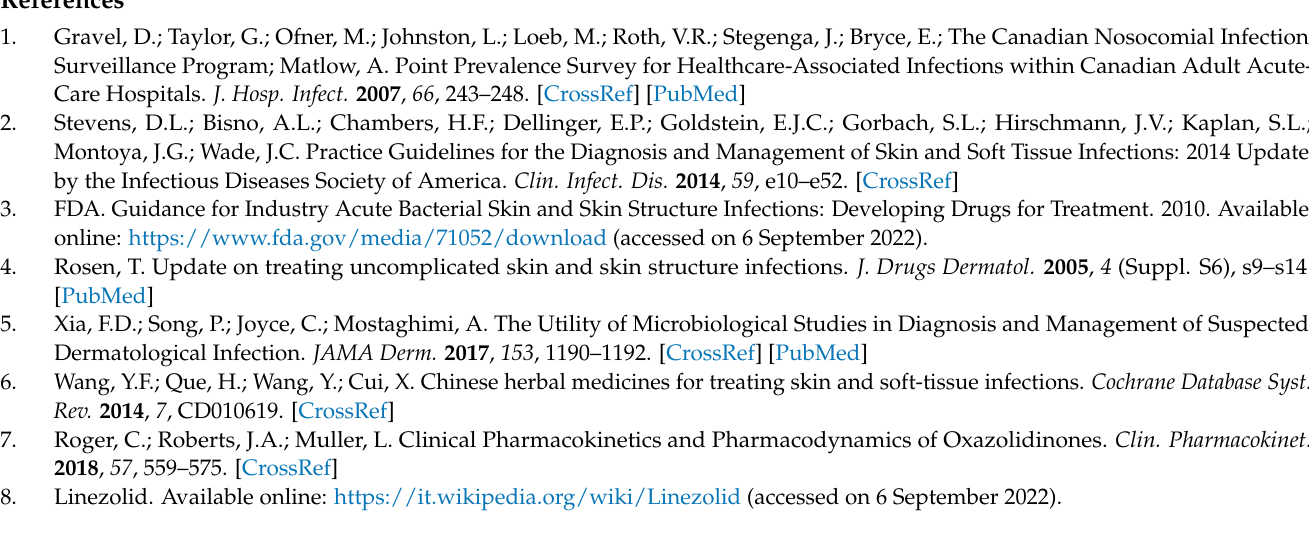
ratio percentages. Figure S7. Cumulative weight loss percentage curves of gel into Ws (green line) and of that into the PD (purple line) (a); Korsmeyer–Peppas kinetic models fitting data of cumulative weight loss curves (b). Table S2. Values of coefficients of determination obtained for all the kinetic models